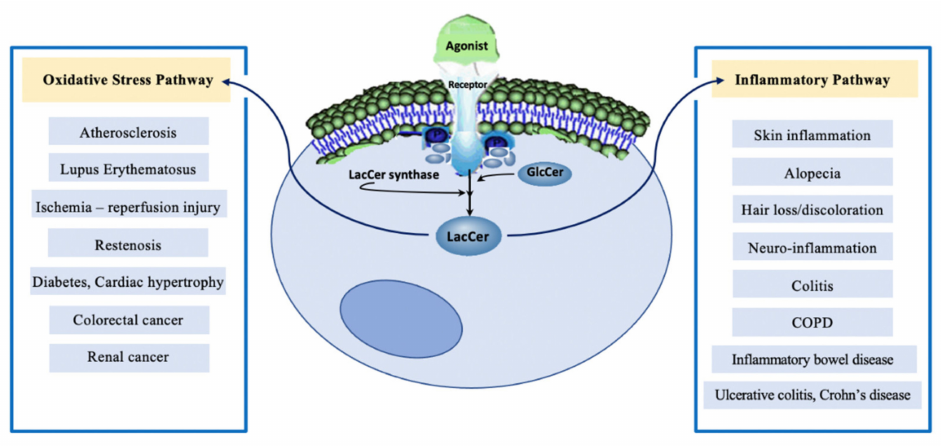
Figure 3. Schema of lactosylceramide in the regulation of multiple pathologies. Diverse agonists activate LacCer synthase to generate LacCer. LacCer induces two main pathways-oxidative stress and inflammatory. The oxidative stress pathway contributes to several pathologies: atherosclerosis, lupus erythematosus, ischemia, restenosis, diabetes, colorectal cancer, and renal cancer. The inflamma- tory pathway contributes to skin inflammation, alopecia, hair loss/discoloration, neuro-inflammation, colitis, chronic obstructive pulmonary disease (COPD), inflammatory bowel disease, ulcerative colitis (UC), and Crohn’s disease